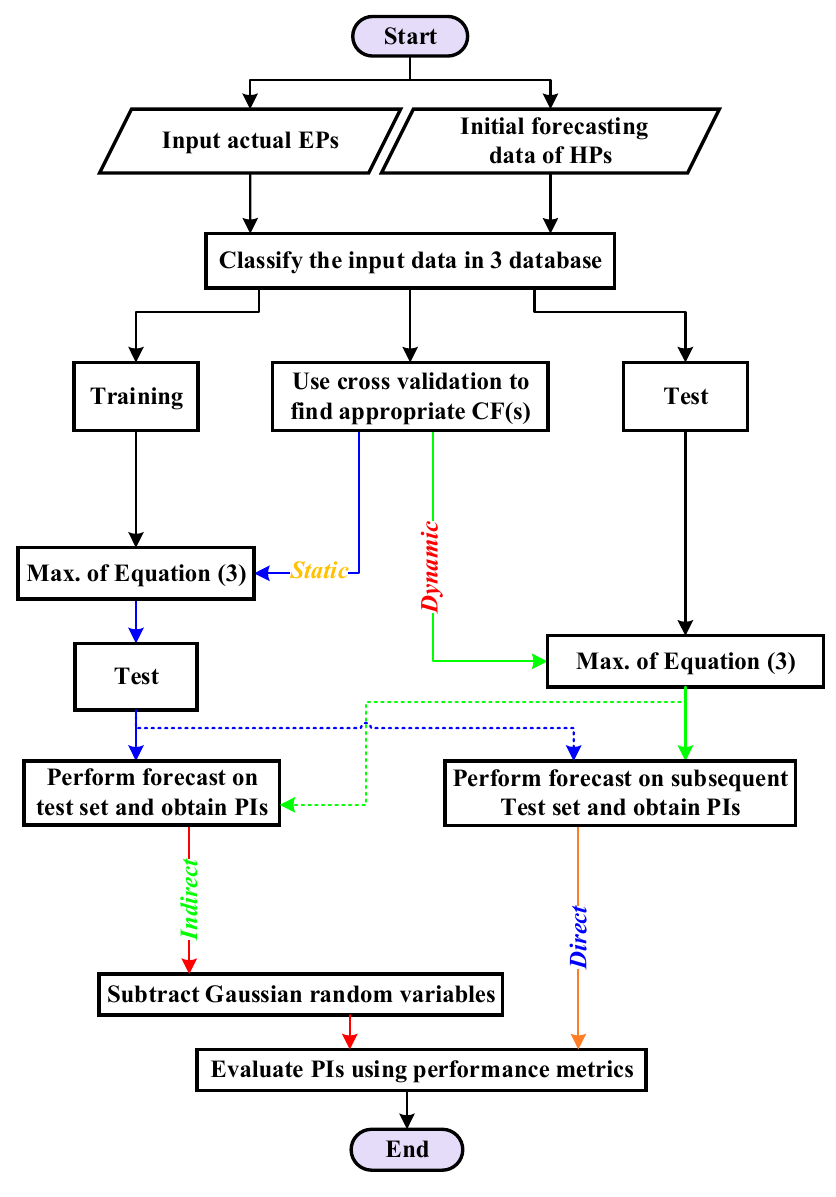
Figure 2. The flowchart of the proposed method.